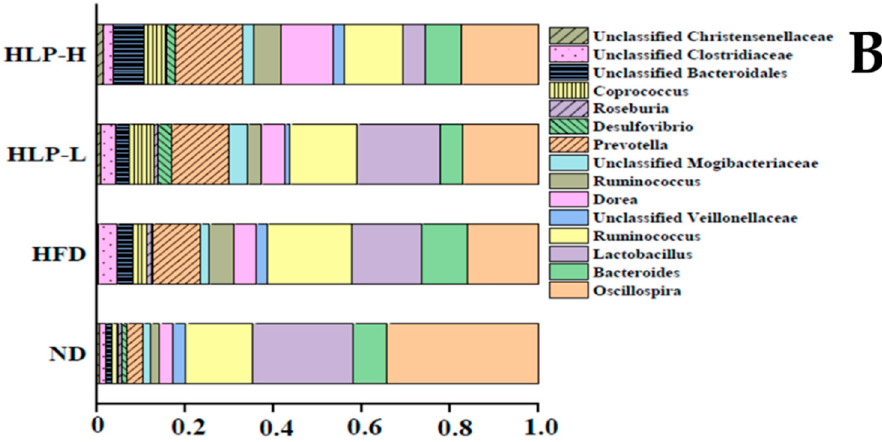
Figure 3. Effects of HLP on the gut microbiota. Principal component analysis (PCA) score plot for the gut microbiota ( A ). The bacterial community at the genus level in the guts of the rats ( B ) ( n = 6).